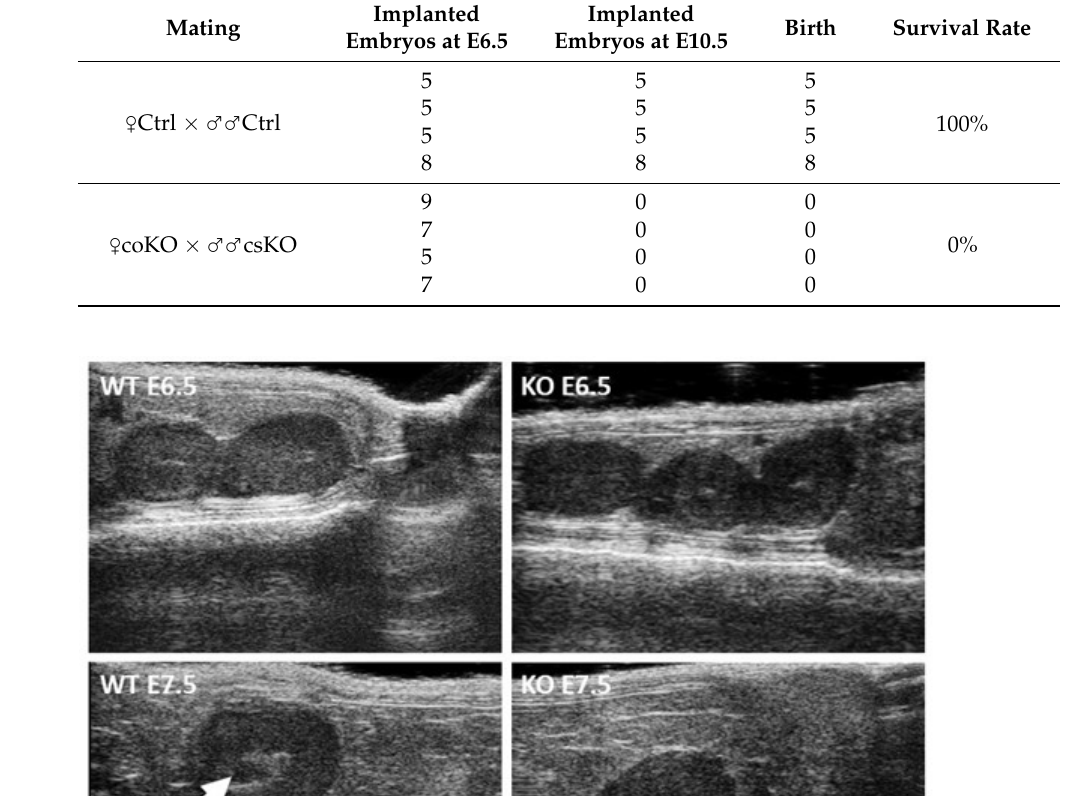
Table 1. Survival rate after crossbreeding of csKO males and coKO females or control (Ctrl) mice measured by ultrasound microscopy.